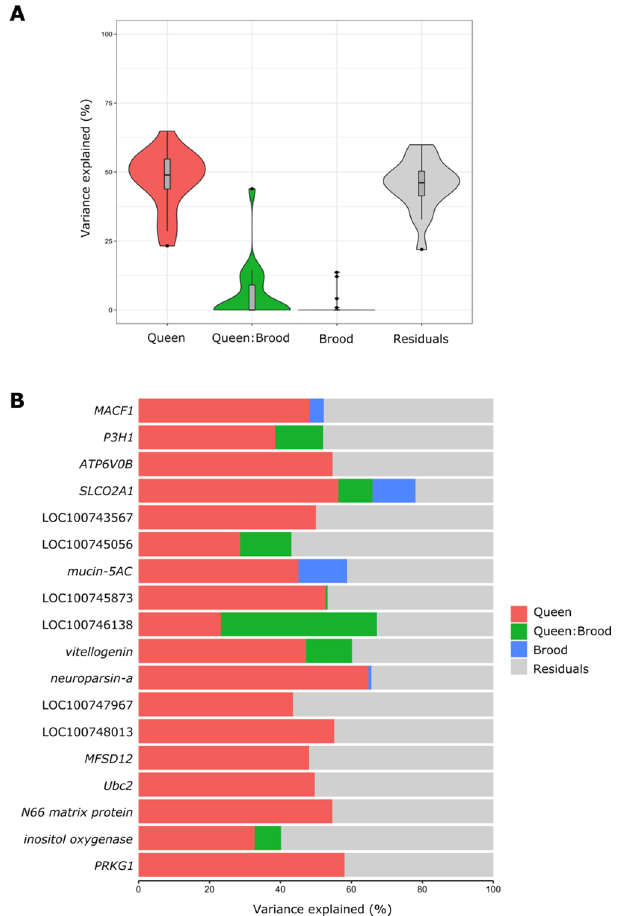
Figure 4. The percentage of variance in the differentially expressed genes explained by selected variables. ( A ) The percentage of variance explained by the presence of the queen, brood, their joint presence, and the residuals; ( B ) the percentage of variance explained by the queen, brood, their joint presence, and residuals for each of the 18 differentially expressed genes identified in the